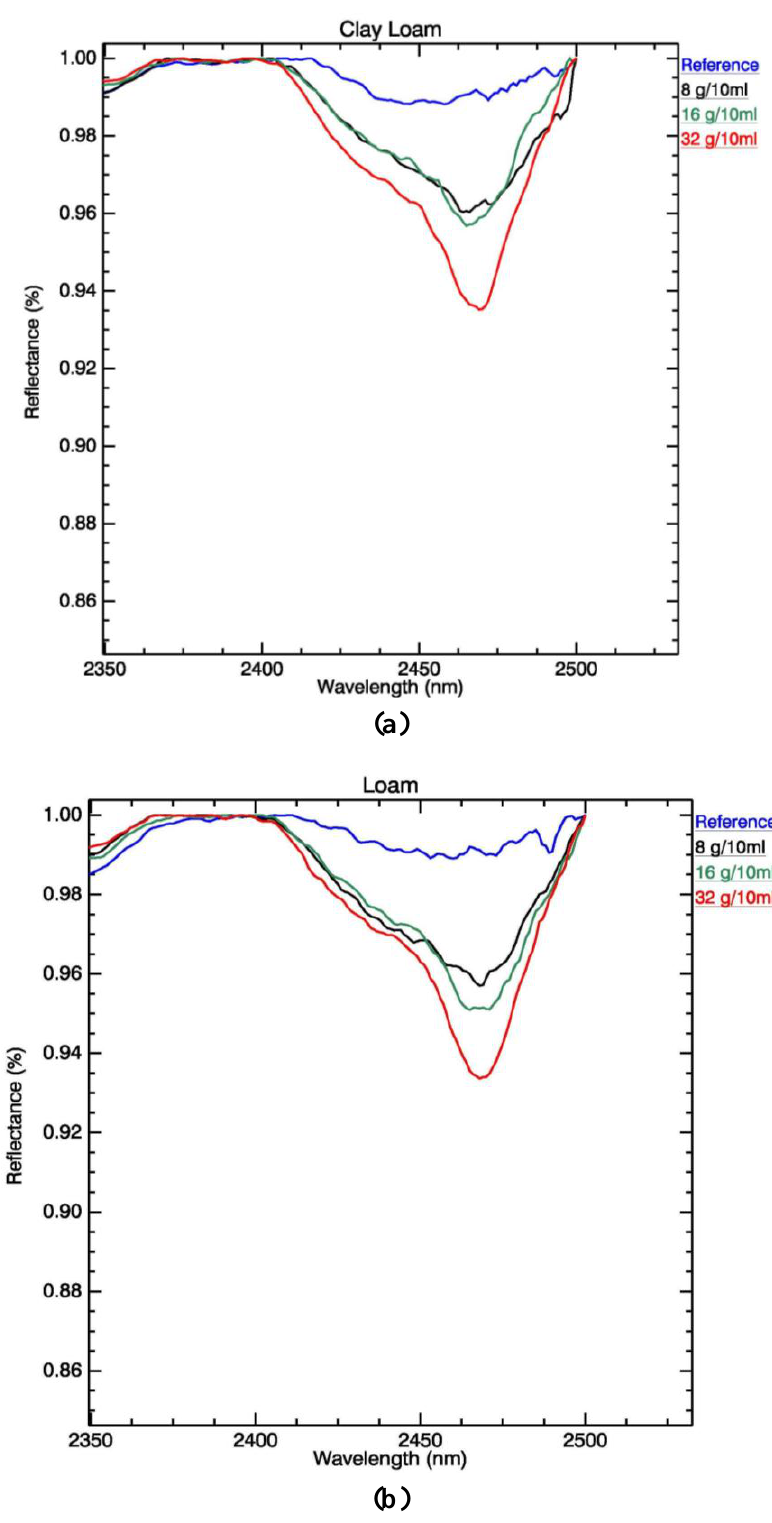
Figure 2. Change in absorption at 2,450–2,470 nm with change in K concentration. Each spectrum is an average of 10 measurements. The blue lines belong to soils with no added fertilizer and used as a reference. The deeper absorption features belong to samples with addition of K fertilizer in concentrations 8, 16 and 32 g/10 mL, indicated with black, green and red line respectively. The sub-figures show: (a) Clay Loam, (b ) Loam, (c) Heavy clay; (d) Coarse sand, (e) Fine sand, (f) Silty